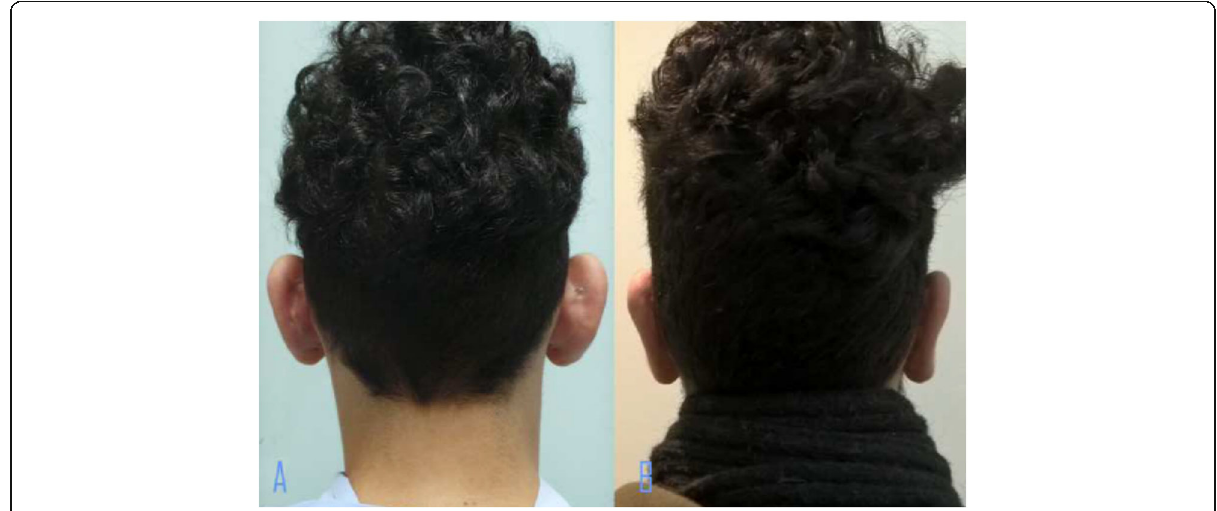
Fig. 8 Preoperative and postoperative pictures of a 27-year-old male patient showing the amount of regression in auricular